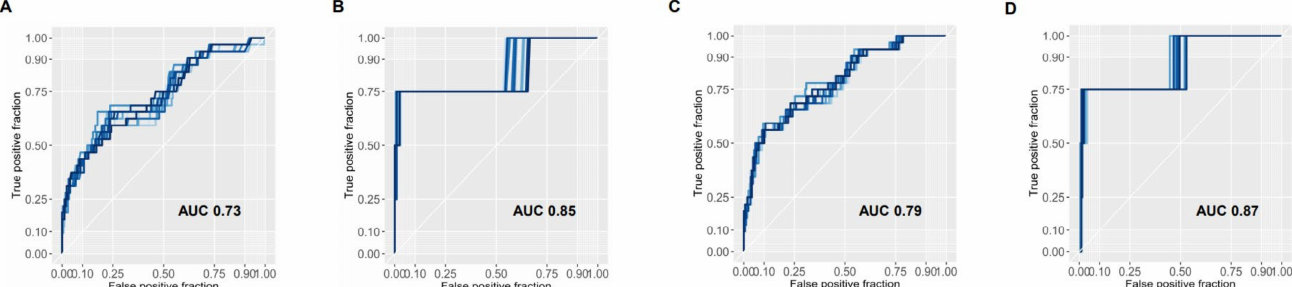
Figure 1. Performance of preoperative and postoperative models across imputed datasets Areas under the curves are shown for the preoperative model as well as the postoperative model for the primary endpoint of occurrence of major complications ( A , C ) and the secondary endpoint of mortality ( B , D ). Every curve represents one iteration of 20 imputed datasets for missing variables. The mean AUC for each model is